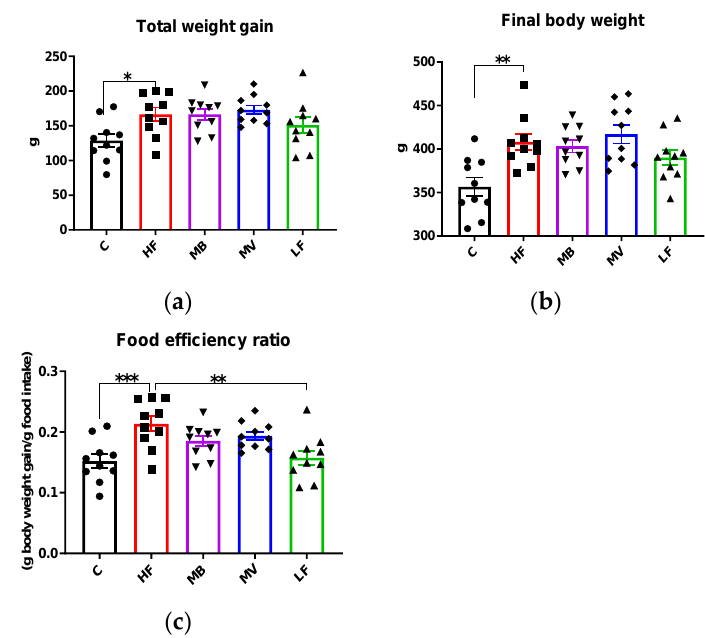
Figure 4. Total weight gain ( a ), final body weight ( b ), and food efficiency ratio ( c ) in conventional rats fed a pure high-fat diet (C), or Apolipoprotein E-knockout (ApoE-/-) rats fed a low-fat diet (LF) or high-fat diet (HF), pure or supplemented with 1% monobutyrin (MB) or monovalerin (MV) for 5 weeks ( n = 10 / group). Rats from the C, HF, MB, MV and LF groups are shown as • , (cid:4) , (cid:72) , (cid:7) and (cid:78) , respectively. Data are presented as means ± SEM. * p < 0.05, ** p < 0.01, *** p < 0.001.